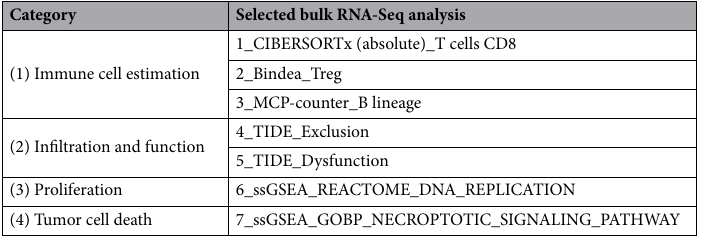
Table 3. Validated transcriptome-based